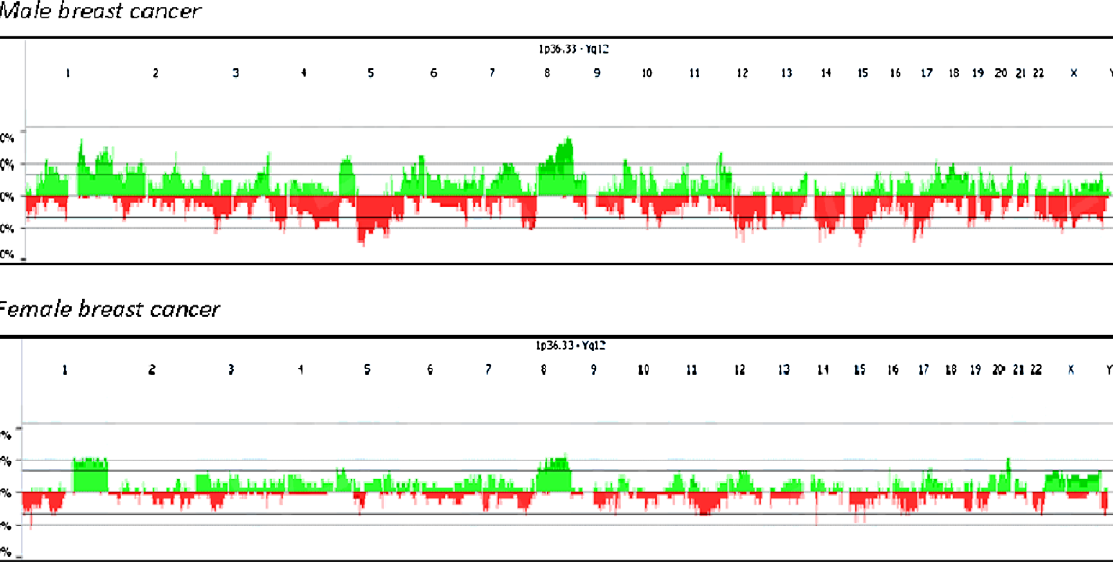
Fig. 1. Frequencies of copy number gains and losses across the male and female genome. Copy number gains (green) and losses (red) are mapped relatively to their position. (The colors are visible in the online version of the article; http://dx.doi.org/10.3233/ACP-CLO-2010-0544.) gions resulted specifically altered in male or in female